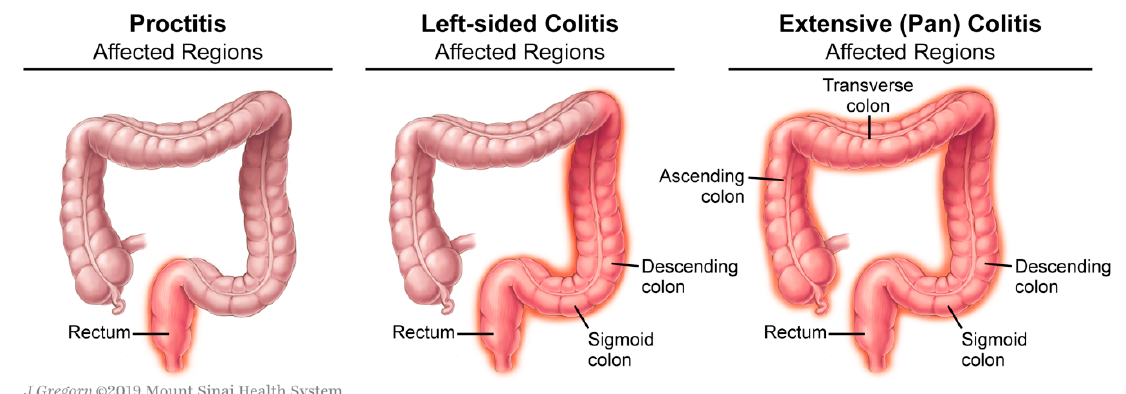
Figure 1. Ulcerative colitis disease extent.